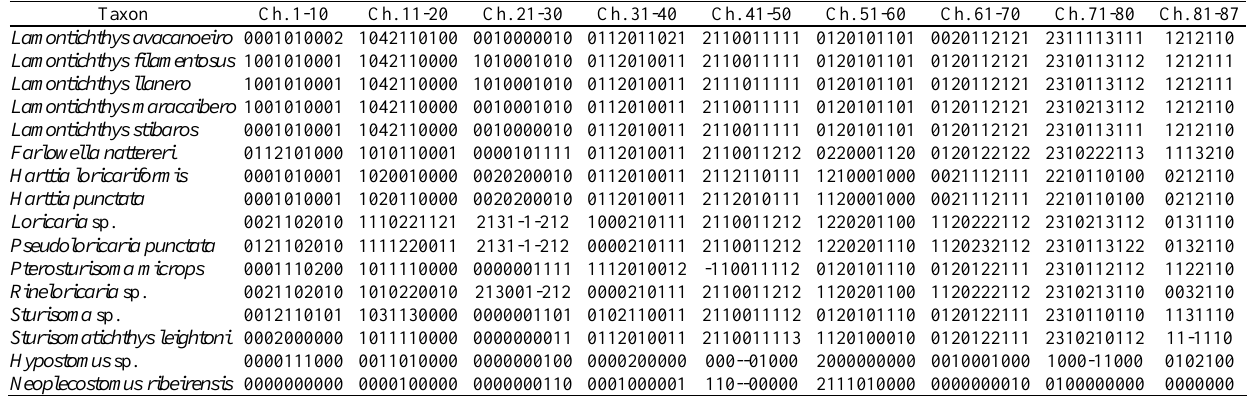
Table 4. Character matrix for species of Lamontichthys , representatives of the Loricariinae, and the